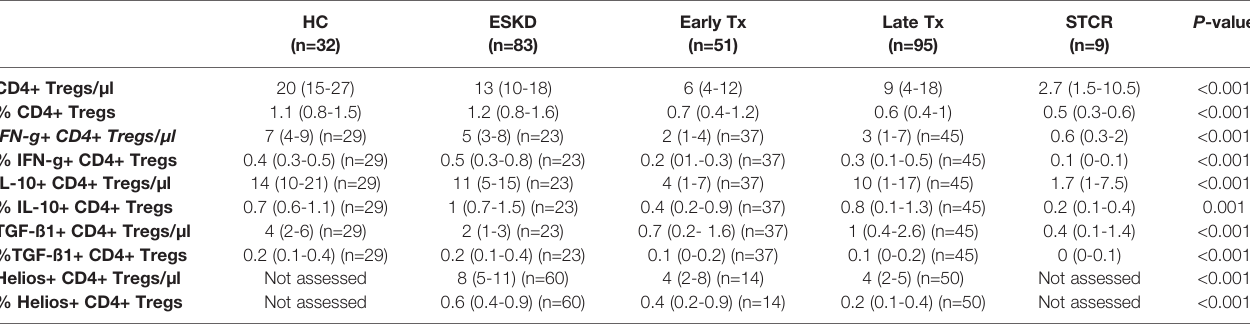
TABLE 3 | Comparison of the absolute and relative counts of IFN-g+, IL-10+, TGF-ß1+, and Helios+ CD4+CD25+CD127-Foxp3+ cell subsets in healthy controls (HC), end-stage kidney disease patients (ESKD), early and late renal transplant (Tx) patients, and renal transplant patients with a recent steroid-treated acute cellular rejection